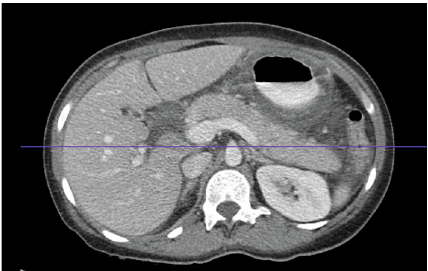
Figure 1: CT abdomen image obtained in Emergency Department indicating fi ndings consistent with pancreatitis.